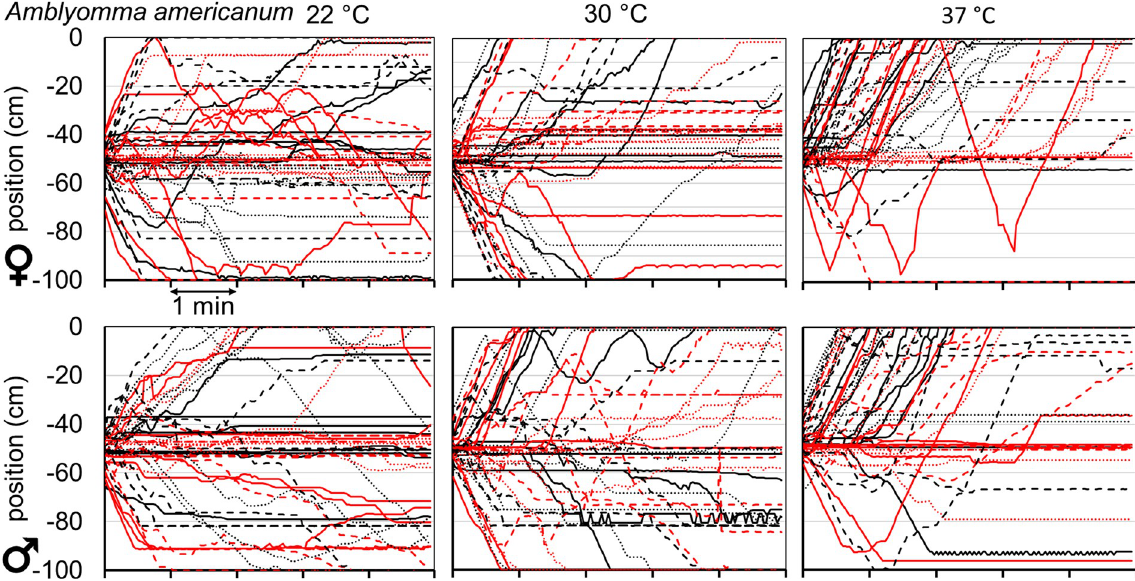
Fig 2. Tracks of individual Amblyomma americanum ticks in thermotaxis trials. Longitudinal position vs. time in the 1m-long arena of 48 individual female (top) or male (bottom) A . americanum ticks (six runs of eight ticks, with a different color/line type combination for each run) after placement in the center, at -50 cm, with the target plate (22, 30 and 37 ˚C in left, center and right panels, respectively) at 0 cm and the cold plate at -100 cm. Horizontal axis units are minutes.